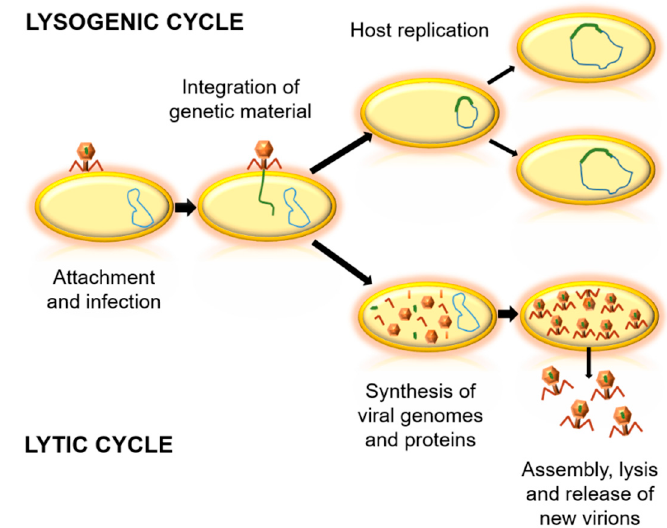
Figure 1. Biological cycles of phages. Firstly, the virus binds to the bacterial cell and injects its genetic material. In the lysogenic cycle, the integration of viral genetic material into the genome of the host occurs, and the bacterial cell replicates without producing virions. In the lytic cycle, viral genetic material is replicated and viral proteins are synthesized. Then, an assembly of virions is achieved, followed by the lysis of the bacteria and the release of new virions.